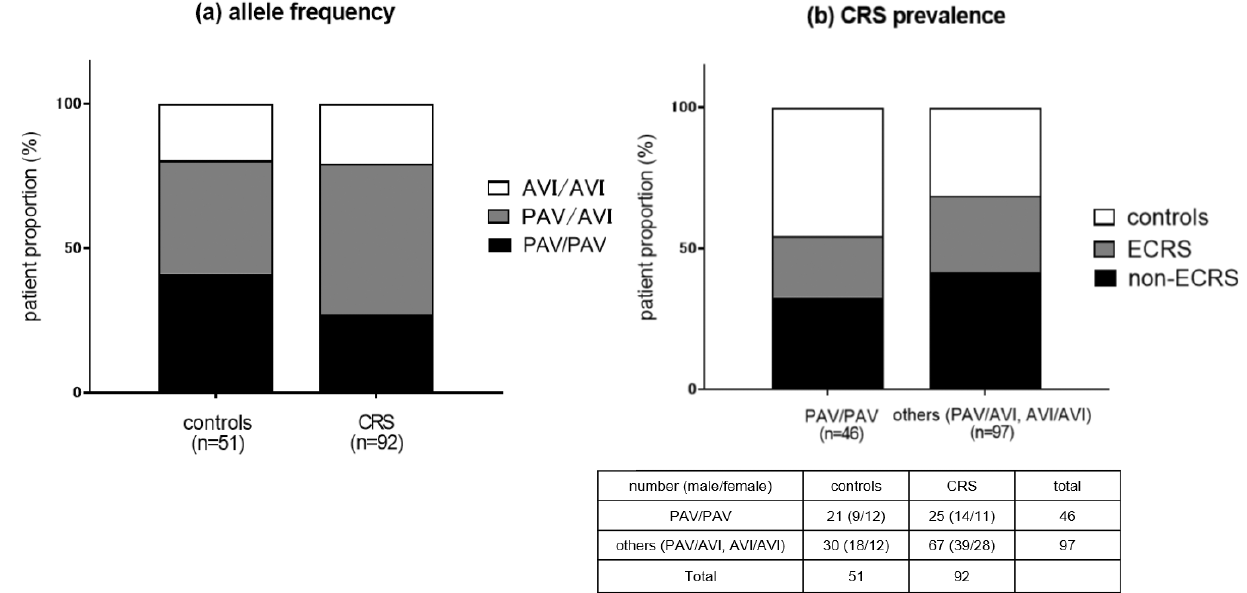
Figure 1. ( a ) Proportions of the PAV/PAV allele and other alleles (PAV/AVI and AVI/AVI) in the control and CRS groups. ( b ) CRS prevalence classified by TAS2R38 gene polymorphisms (PAV/PAV vs. PAV/AVI and AVI/AVI